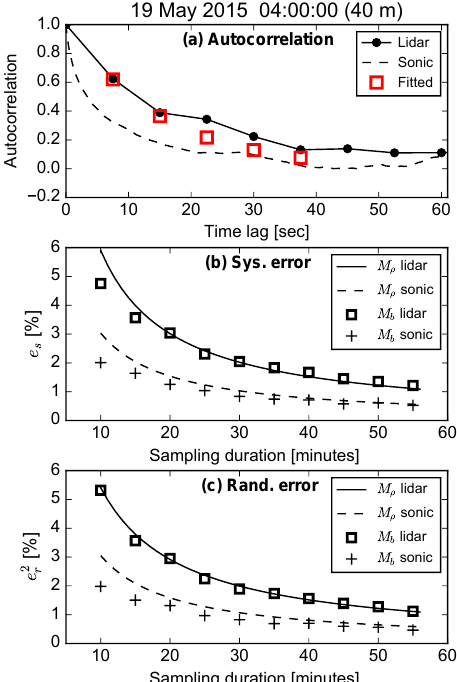
Figure 6. An example of the autocorrelation and errors in radial ve- locity variance estimate using data from the hour starting at 19 May 2015 04:00 at 40m height. The autocorrelation functions derived from the lidar and sonic measurements are presented in (a) . Sys- (cid:16) (cid:17) e 2 r tematic errors (e s ) and random errors are presented in (b) and (c) , respectively. Errors associated with both lidar and sonic anemometer data are estimated using the autocorrelation function from measurements (denoted by M ρ ) and the stationary bootstrap method (denote by M b ) described in Sect.